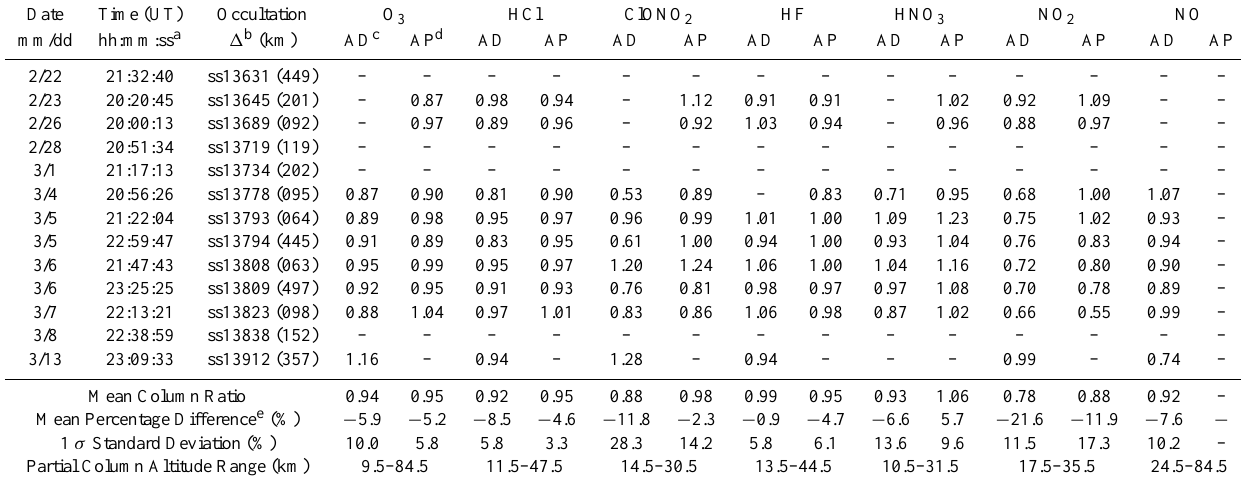
Table 5. Ratios of partial columns ([ACE-FTS]/[ground-based FTS]) obtained during the 2006 Canadian Arctic ACE Validation Campaign.